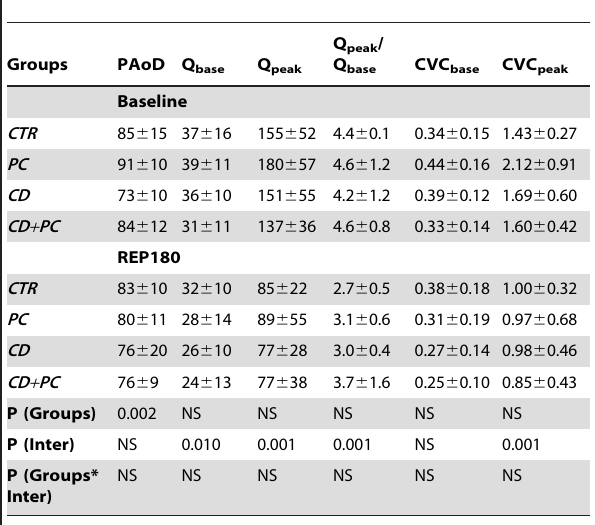
Table 2. Summary of coronary reactive hyperemia responses.